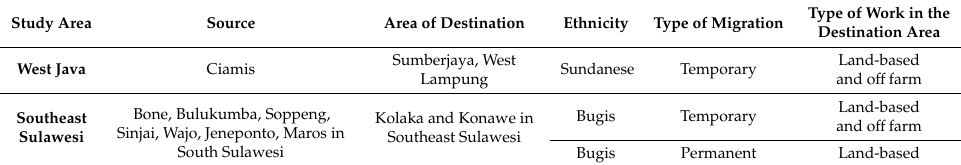
Table 1. Characteristics of migration in the study